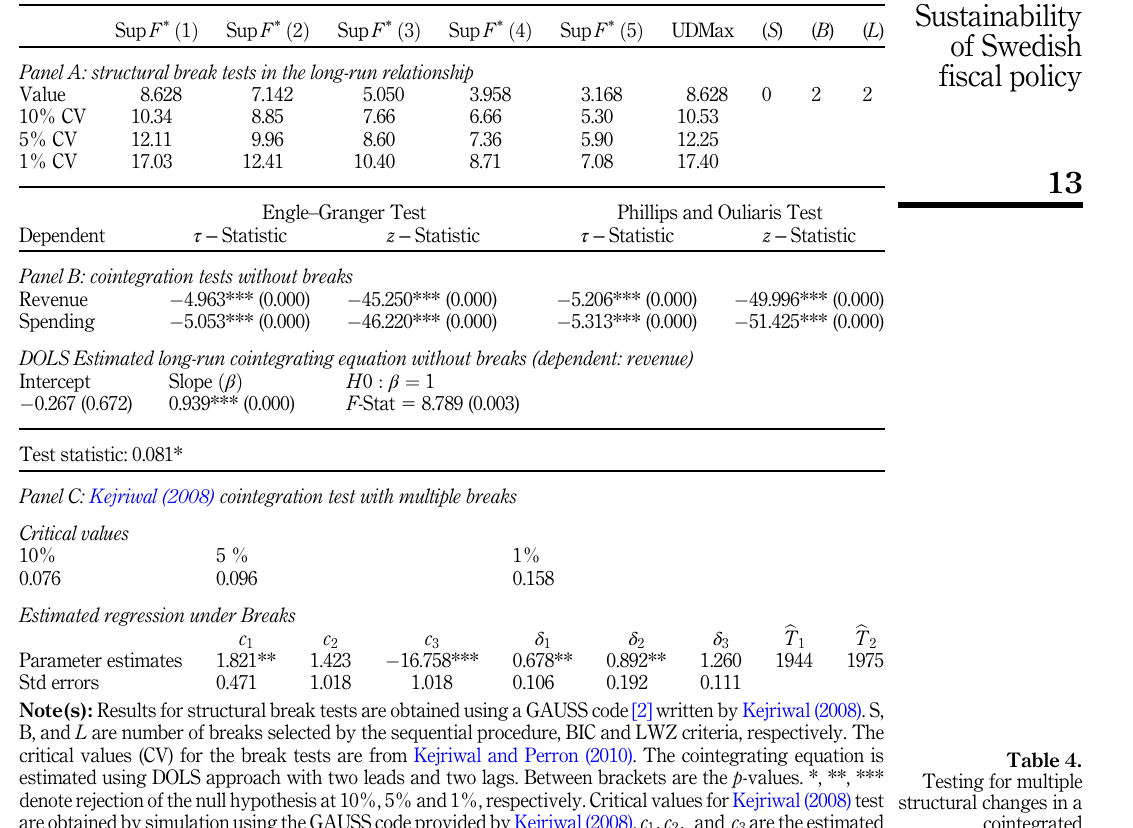
Table 4. Testing for